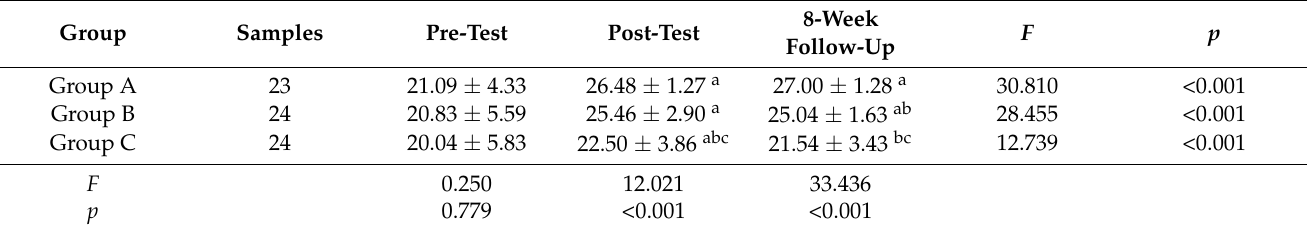
Table 3. MMSE scores in A, B, C ground at T 0 , T 1 , T 2 in terms of mean ± standard error (SE).